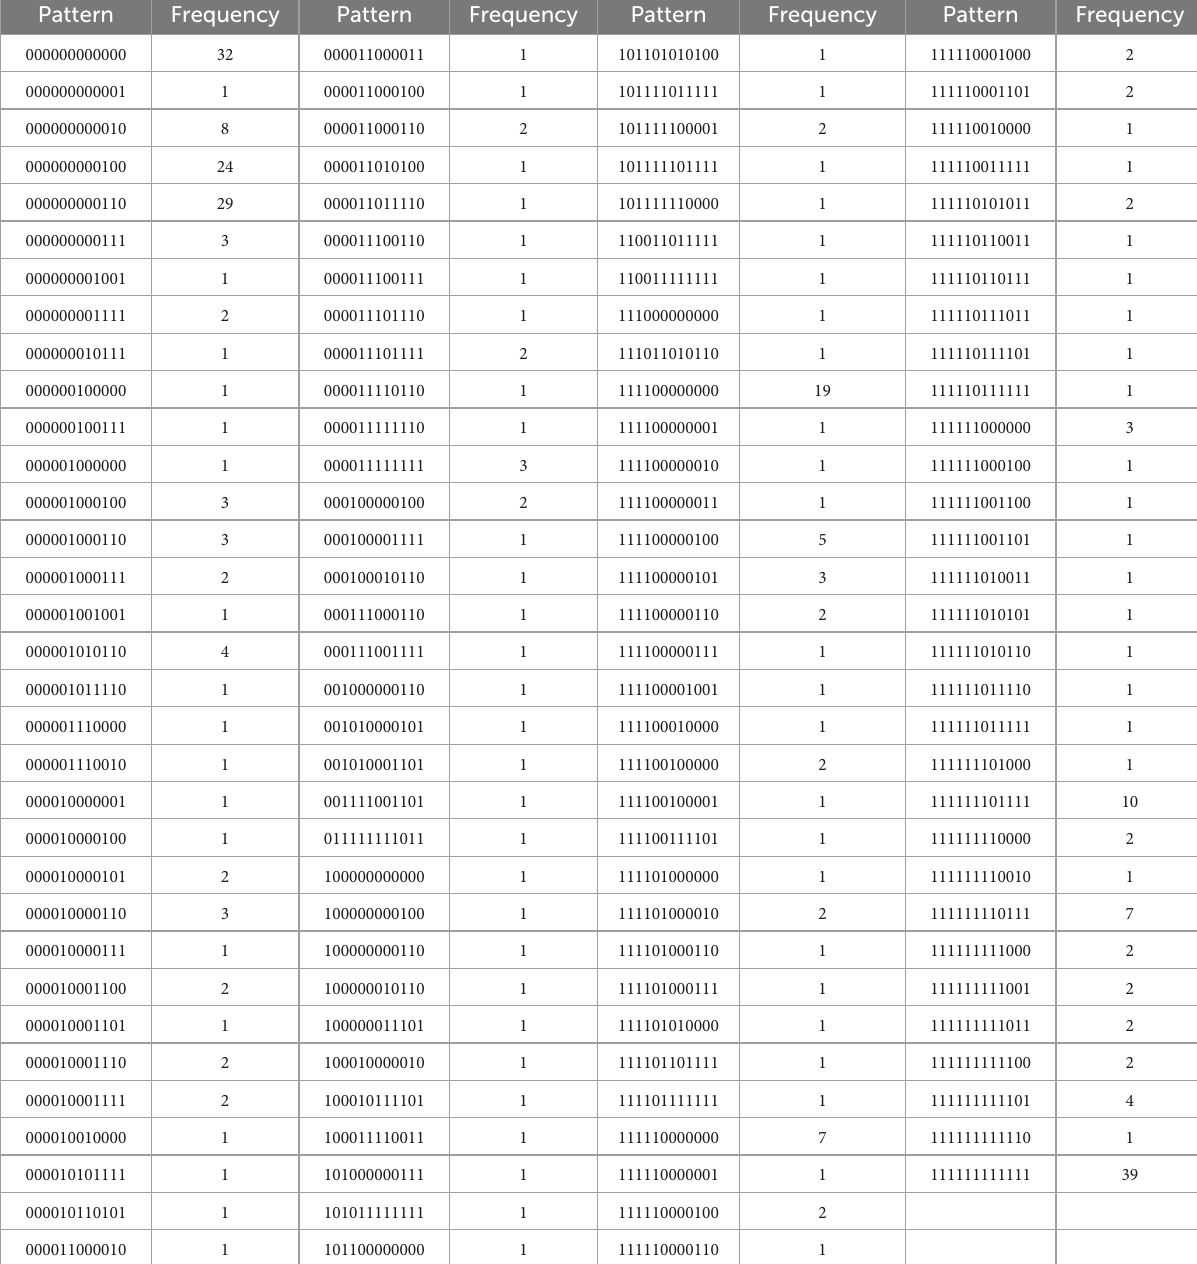
TABLE 4H For A = { i 1 , i 3 ,..., i 5 , d 5 , j 1 ,..., j 4 , e 3 , e 4 , e 5 } , with N = 342, k = 12 items, and u = 130 unique response patterns ( Appendix B